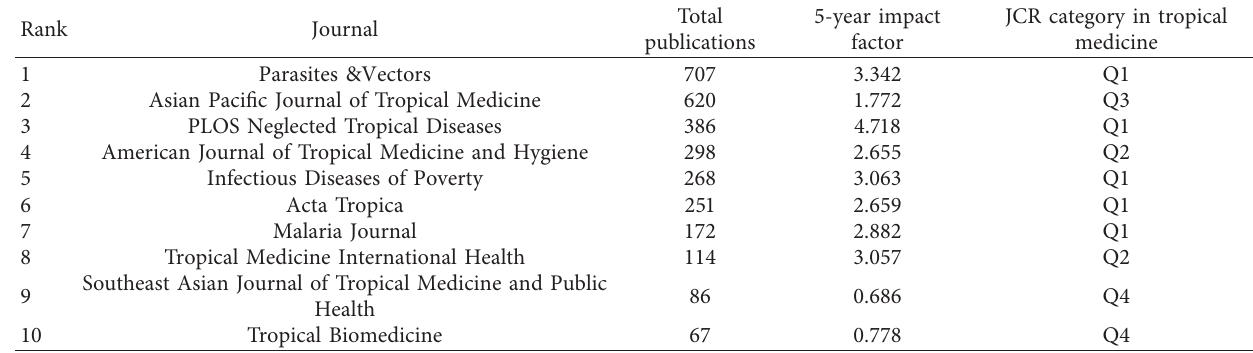
Table 2: The top 10 journals of tropical medicine related publication, 2010–2019.